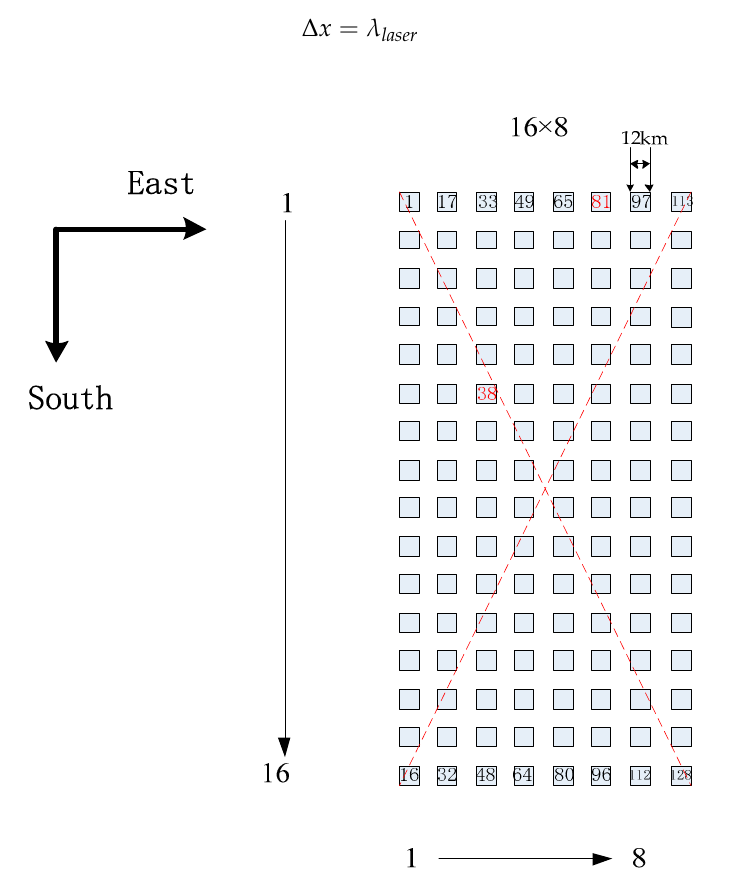
Figure 6. The placement of detectors in the focal plane of the Geostationary Interferometric Infrared Imager (GIIRS).